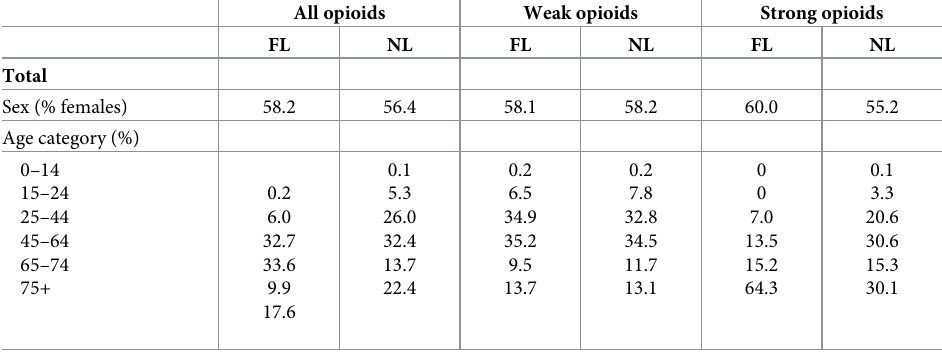
Table 2. Age and sex distribution of patients with an opioid prescription at the out-of-hours service, in Flanders and the Netherlands in 2019. All